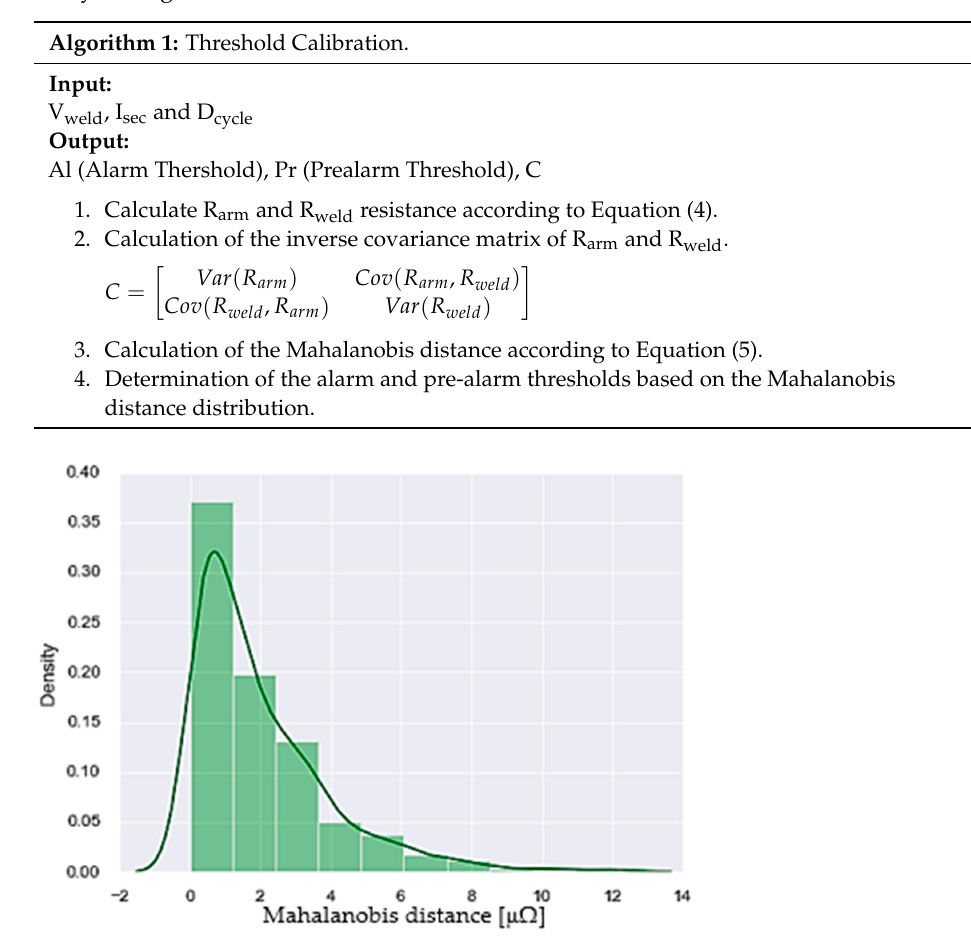
Figure 10. Mahalanobis distance